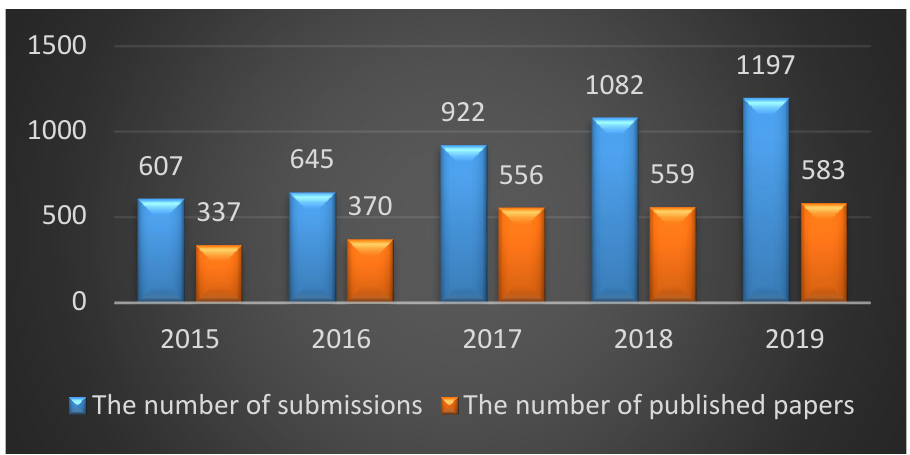
Figure 1. Number of submitted manuscripts (blue bars) and published papers (orange bars) in the Medicinal Chemistry section of Molecules in the period 2015–2019.